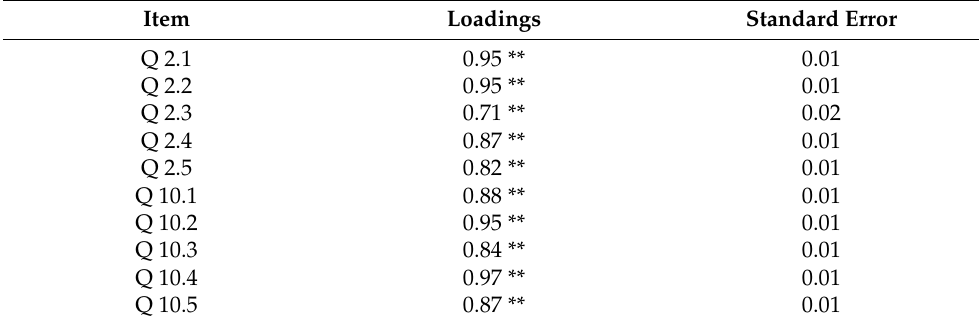
Table 7. Factorial structure of unidimensional